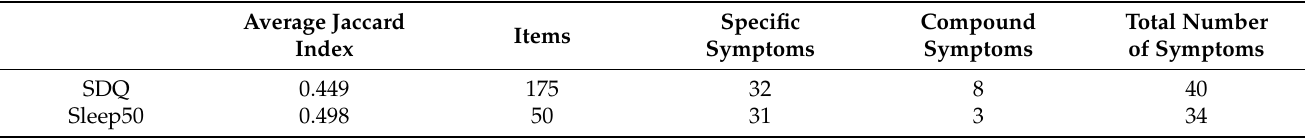
Table 1. Average Jaccard index, number of specific and compound symptoms that appear across self-reported multiple sleep disorder screening questionnaires. ICSD: International Classification of Sleep Disorders, DSM: Diagnostic and Statistical Manual of Mental Disorders, SDQ: Sleep Disorder Questionnaire, ASQ: Auckland Sleep Questionnaire, HSDQ: Holland Sleep Disorders